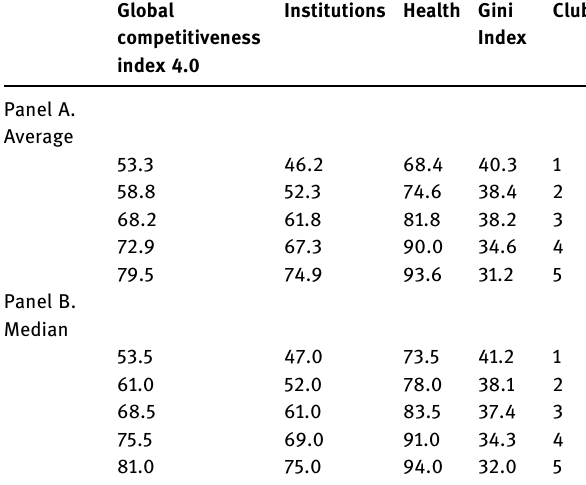
Table 6: Median and mean scores